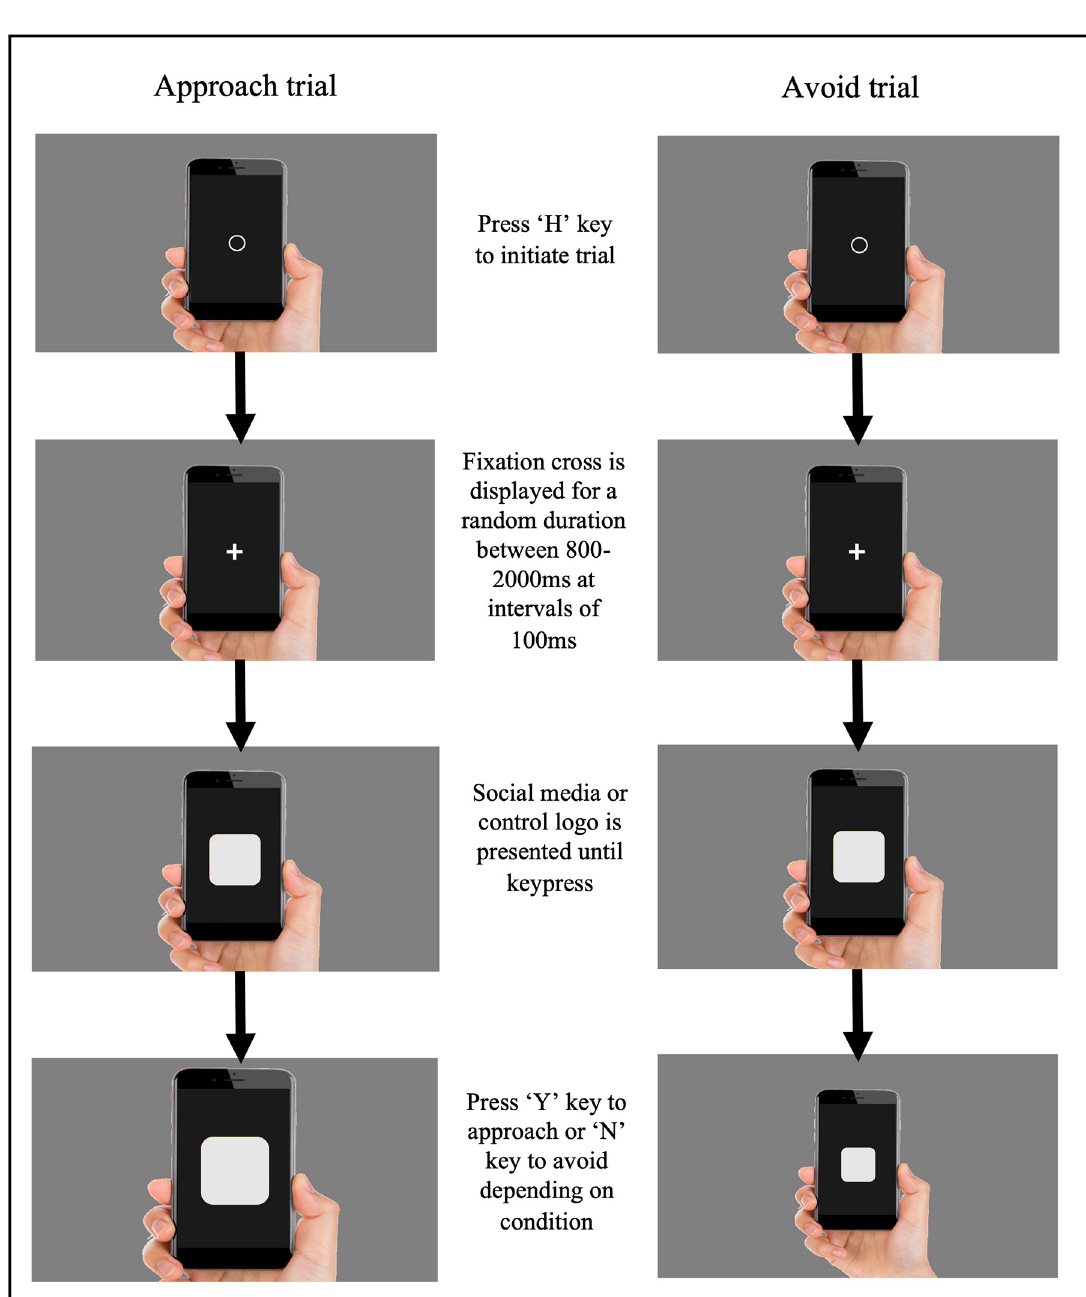
Fig 1. Example of the trial sequence in the social media VAAST with an approach instruction (left) and avoid instruction (right). Social media and control app logos have been removed for copyright reasons. https://doi.org/10.1371/journal.pone.0264738.g001 5-item Likert-scale. A cue reactivity score was calculated for each participant by subtracting the average response to control logos from the average response to the social media logos. Wanting vs . liking . Participants were asked to respond to four statements that assessed the extent to which they enjoyed using social media (e.g., “Using social media is an activity that gives me pleasure”), and four statements that assessed the extent to which they experience